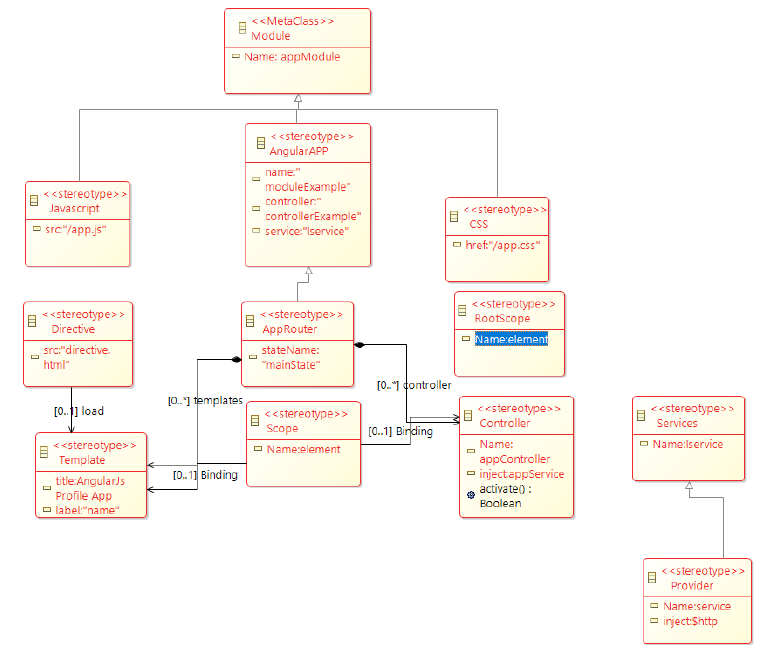
Fig. 6. Study case of AngularJS Application